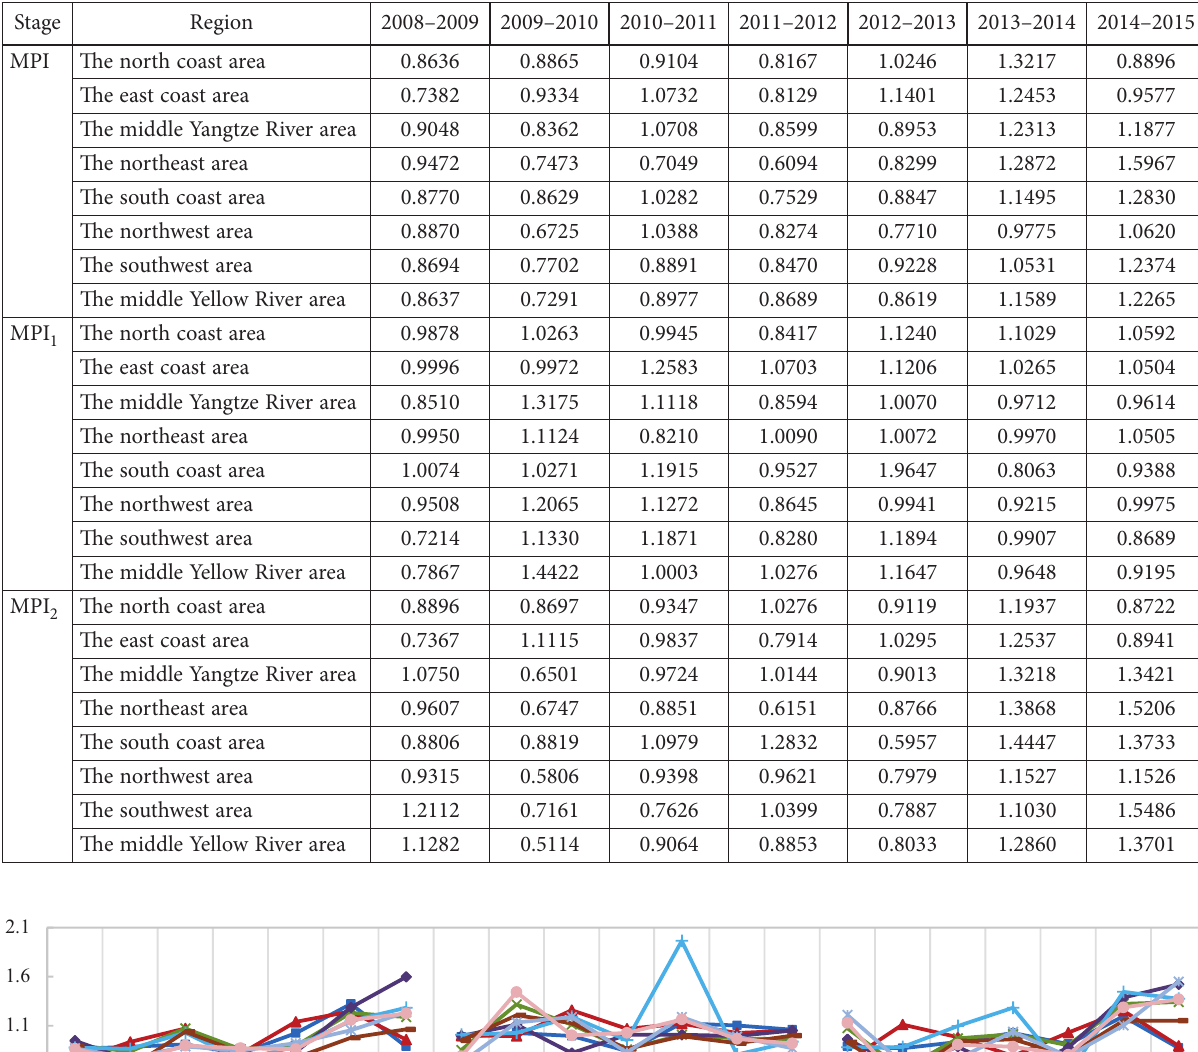
Table 6. The common-weight global MPI in eight regions from 2007 to 2015